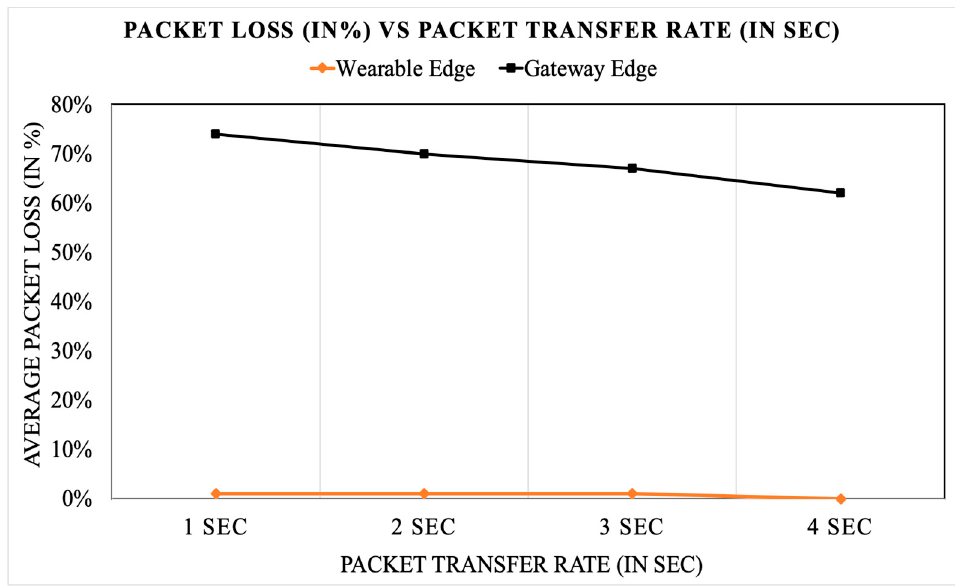
Figure 8 . Average packet loss when acquired data are processed and compressed at the wearable edge or gateway edge for an active five-node network. Processing at the wearable sensor age offers significant improvement in terms of system performance.